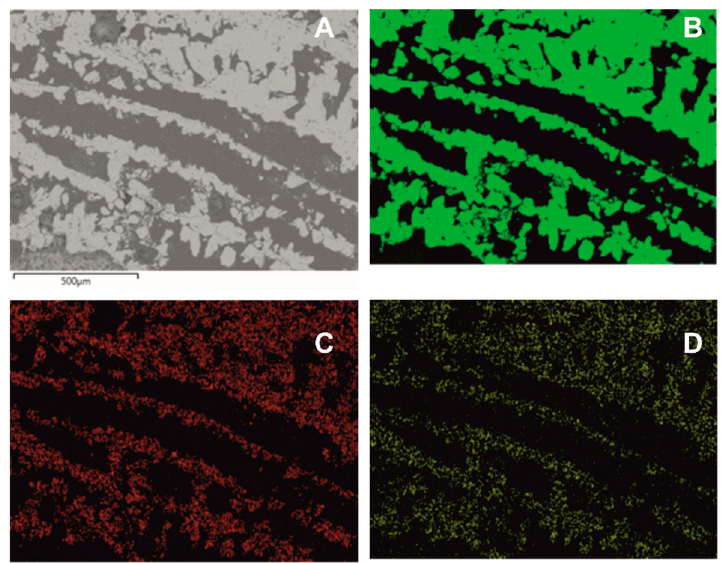
Figure 4. Back-scattered electron images (BSEI) of ( A ) laminated stalactite from Aedipsos; ( B – D ) are false color BSEI results of the mapping, displaying the distribution of ( B ) Ca (green), ( C ) S (red), and ( D ) Yb (yellow). Table 2. Identified Cyanobacteria